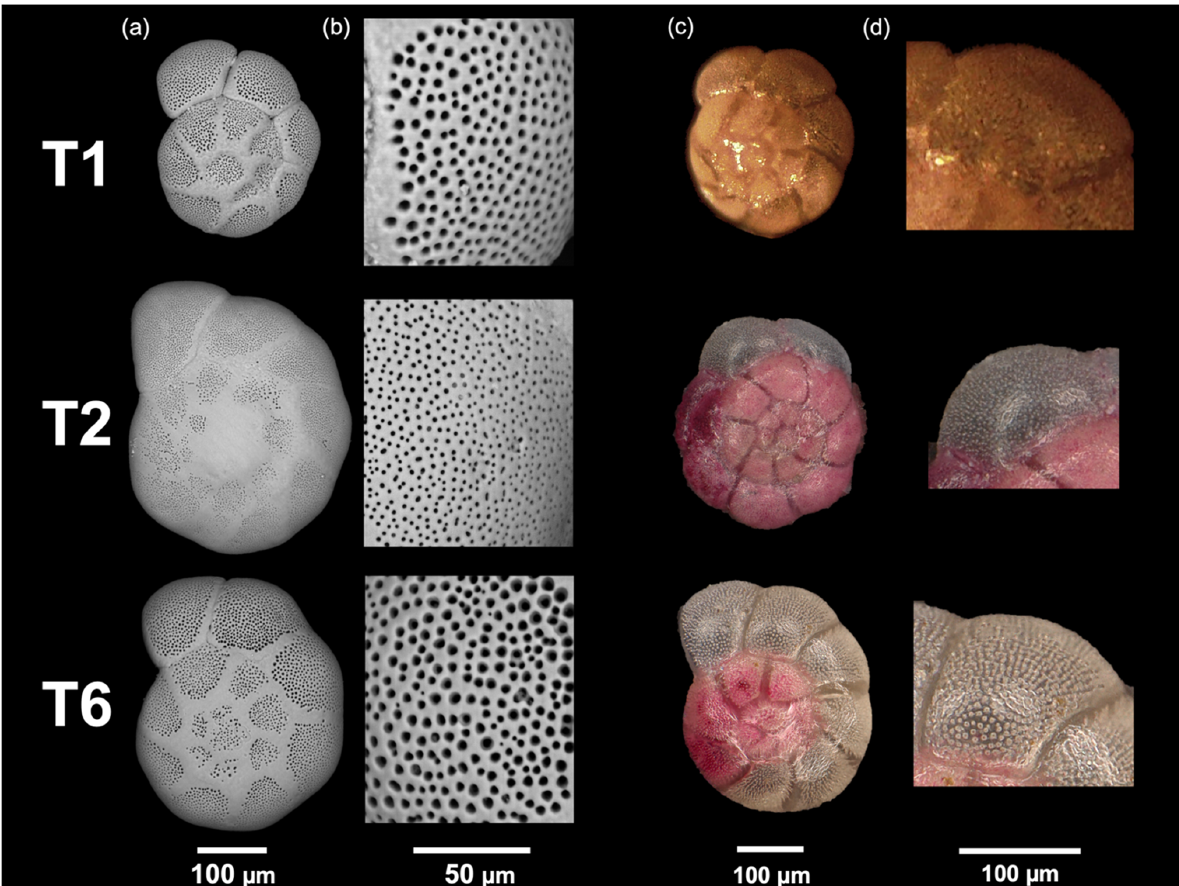
Figure 2. SEM pictures (from Richirt et al. [12]) of ( a ) general overview of the spiral side, ( b ) general overview of pores of the penultimate chamber, and stereomicroscope pictures of ( c ) general overview of the spiral side and ( d ) general overview of pores of the penultimate chamber of phylotypes T1, T2, and T6. ( a , c ) represent the suture elevation character (“flush” for T2 and T6, “raised” for T1), ( b , d ) represent the pore diameter character (small pores for T2, large pores for T1 and T6).